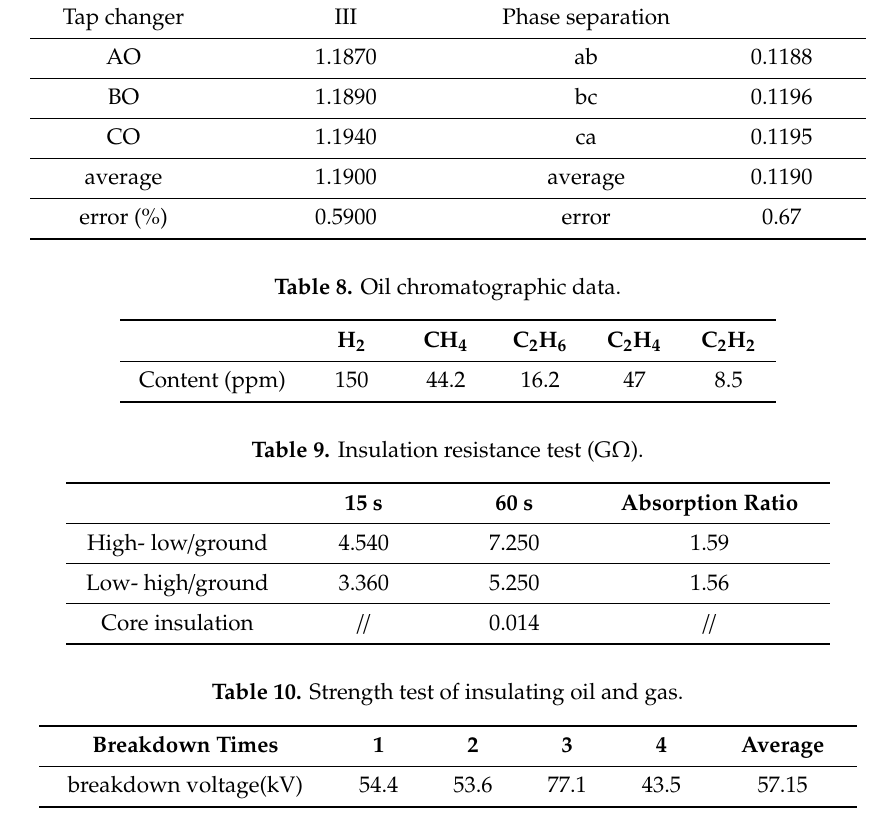
Table 11. Dielectric loss of winding.